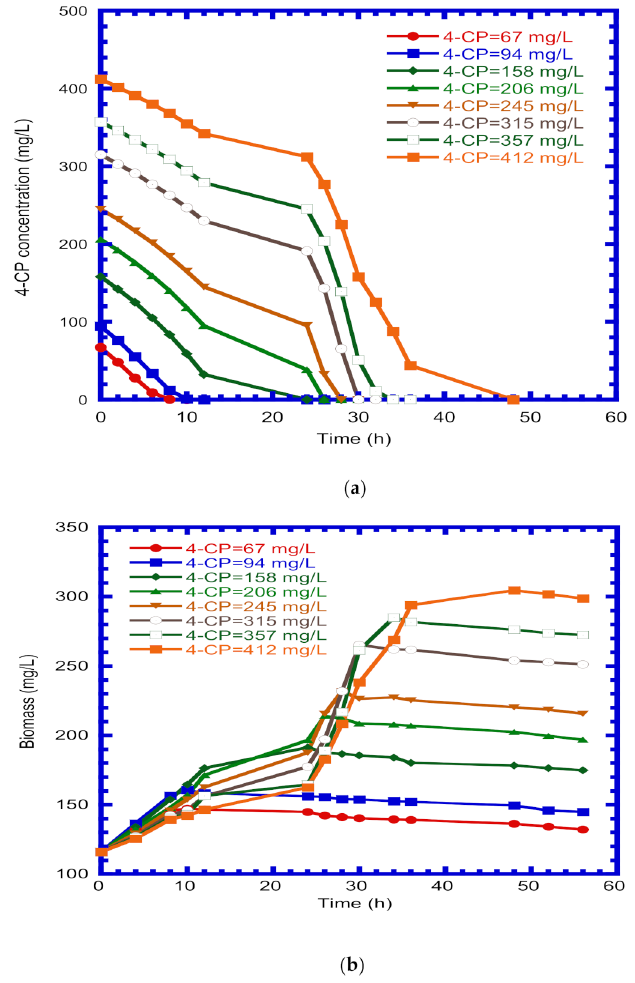
Figure 2. Batch experiments to observe the time-course variations of 4-CP and acclimated sludge: ( a ) 4-CP degradation; ( b ) biomass